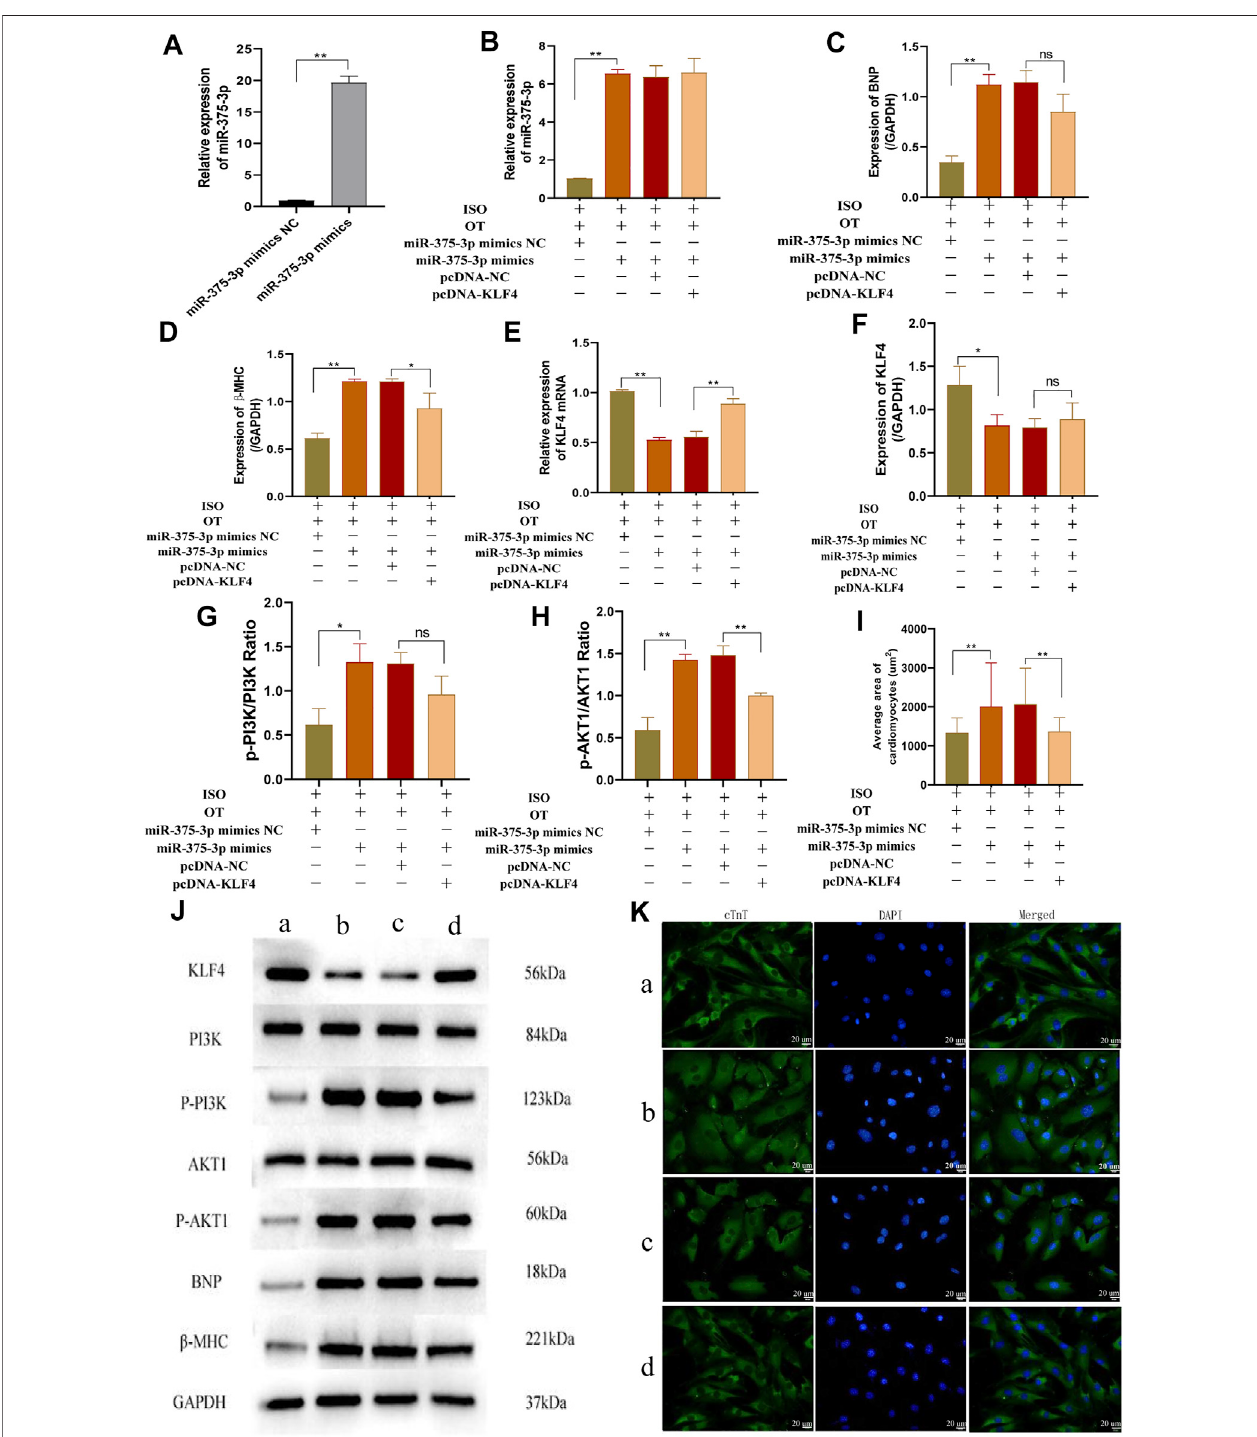
FIGURE8| Over-expressionofmiR-375-3pbluntedanti-hypertrophiceffectsofoxytocinviaKLF4andmodulatedthePI3K/AKTsignalingpathway. (A) Expression of miR-375-3p in cardiomyocytesfollowing transfection ofmiR-375-3p mimicsand miR-375-3p mimics NC. (B) Expression ofmiR-375-3p wasdetectedby qRT-PCR. (C,D) Expressions of BNP and β -MHC proteins were measured by Western blot analysis. (E) Expression of KLF4 mRNA was detected by qRT-PCR. (F) Expression of KLF4 protein wasmeasured byWestern blot analysis. (G) p-PI3K/PI3Kratio. (H) p-AKT1/AKT1 ratio. (I) Statistical resultsofmeasurementofcellsurface areas. (J) Representative western blot images of KLF4, PI3K, p-PI3K, AKT1, p-AKT1, BNP, β -MHC and GAPDH levels. (K) Cardiomyocyte surface areas were measured by immuno fl uorescent staining. Scale bars represent 20 µm. Images were captured at × 400 magni fi cation. (a) ISO+OT+miR-375-3p mimics NC group. (b) ISO+OT+miR- 375-3pmimicsgroup.(c)ISO+OT+miR-375-3pmimics+pcDNA-NCgroup.(d)ISO+OT+miR-375-3pmimics+pcDNA-KLF4group.Dataareshownasthemean ± sdof three independent experiments. *, p < 0.05; **, p < 0.01.